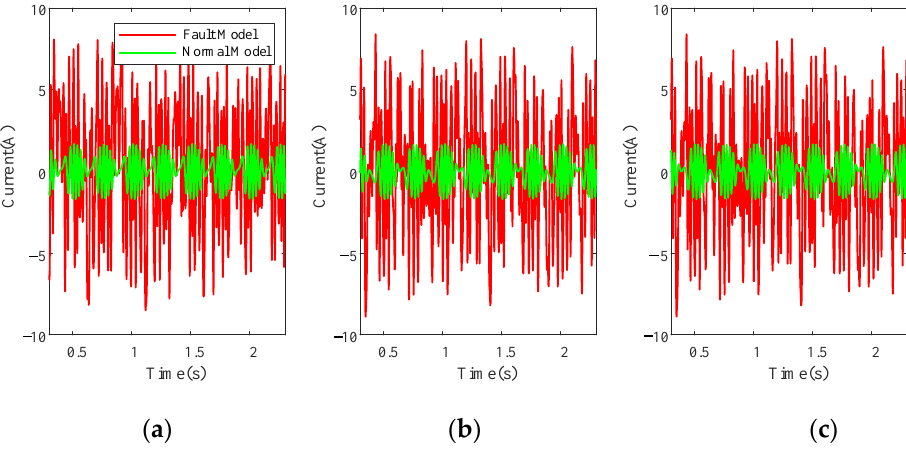
Figure 14. Fault data of velocity sensor open circuit. ( a ) A-phase current; ( b ) B-phase current. ( c ) C-phase current.